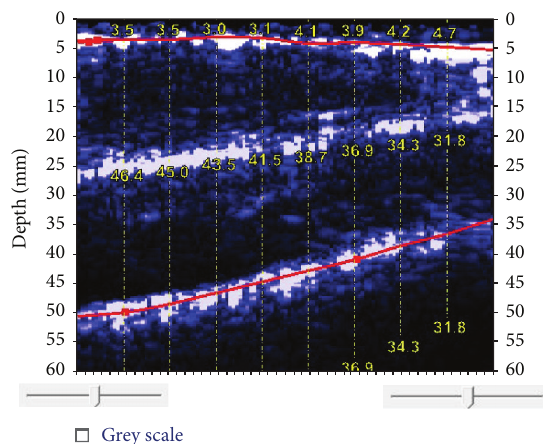
Figure 1: BodyMetrix ultrasound image of thigh. The top line indicates the subcutaneous fat-muscle interface (average thickness of 3.69 mm). The bottom line indicates the muscle-bone boundary. The muscle thickness ranges from 32.0 mm to 46.6mm. The white layer in the center is the boundary of the rectus femoris and vastus